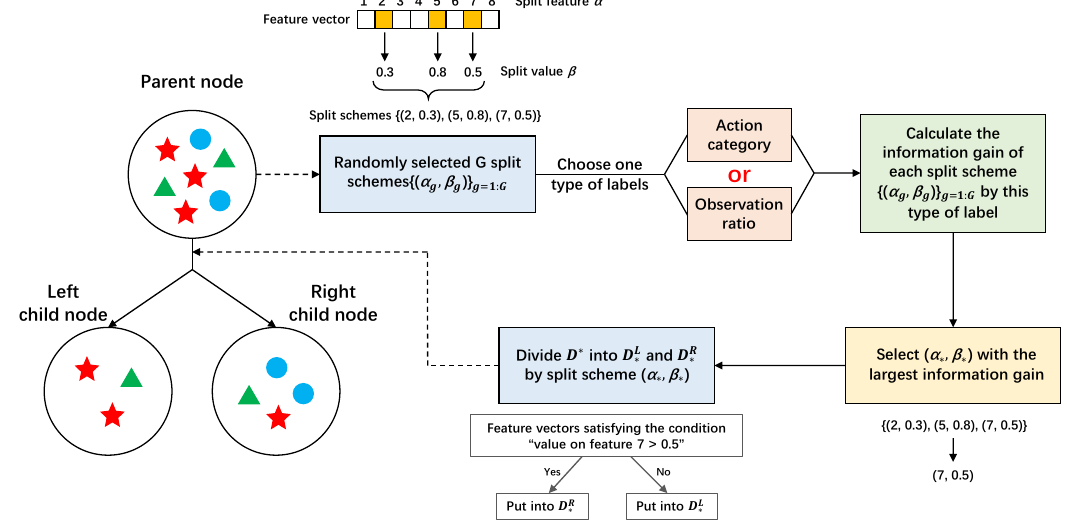
Figure 3. Details of node split for an intermediate node in a multi-task decision